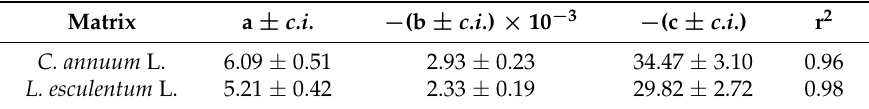
Table 2. Values of parameters involved in Chrastil’s equation, used to correlate the solvent power of Sc-CO 2 to its density and working temperatures. c.i . = confidence interval ( p = 0.05); r 2 = square of correlation coefficient.